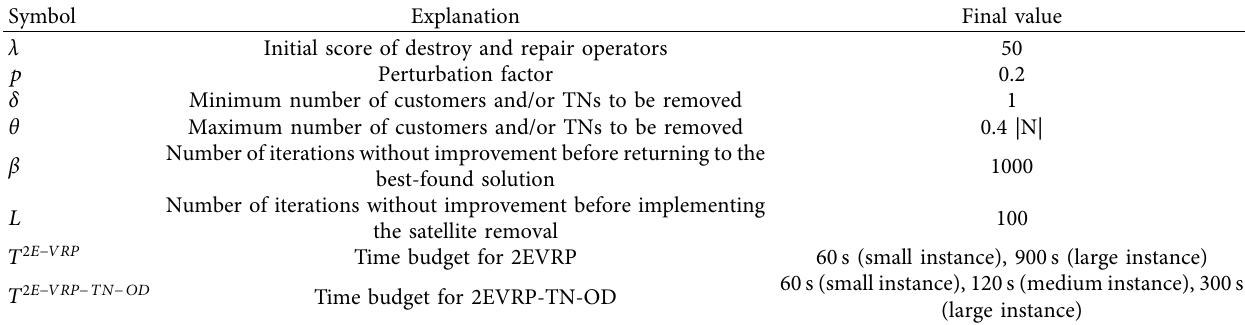
Table 2: Final parameters in the proposed ALNS algorithm.